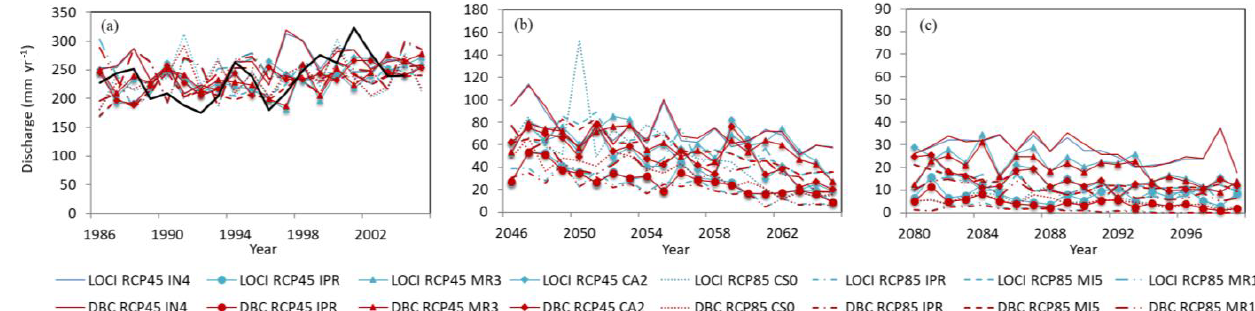
Figure 11. Projected glacier discharges over the upper Beas basin. Projections are shown for the two bias-correction methods (LOCI and DBC) with two ensembles of four GCMs under RCP4.5 and RCP8.5 (Table 2). (a) Glacier discharges in the historical period of 1986–2005 from projections and from the corrected gauge precipitation (black line); (b) projected glacier discharges during 2046–2065; and (c) projected glacier discharges during 2080–2099. Please note the scale change in the y axis in the three sub-figures.